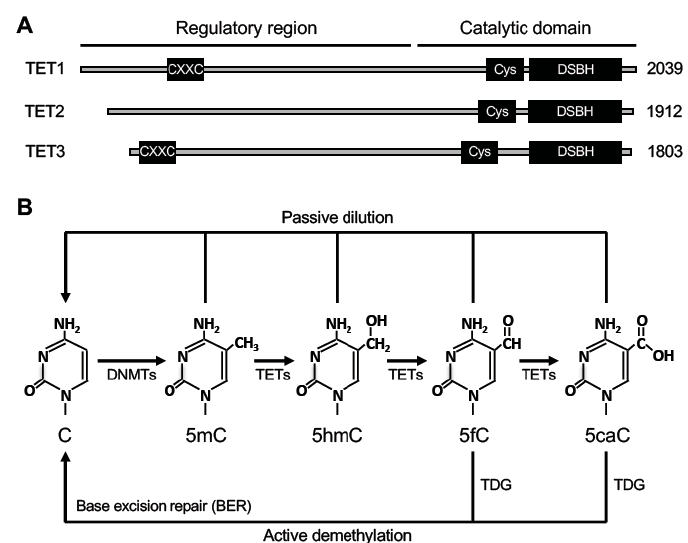
Figure 3. Ten-eleven translocation (TET) proteins and relevant DNA demethylation pathways. ( A ) The protein domains in TET proteins (TET1, TET2 and TET3) are shown (the sizes/amino acid numbers refer to mouse proteins). Their C-terminal catalytic domains contain two characteristic sequence features, a cysteine-rich region (Cys) and a double-stranded β helix (DSBH) fold. Their N-terminal regulatory regions are less conserved, with TET1 and TET3 containing a CXXC zinc finger domain. ( B ) DNA demethylation pathways involving TETs. TET proteins initiate DNA demethylation by oxidizing 5-methylcytosine (5mC) to 5-hydroxymethylcytosine (5hmC), which can be further oxidized to 5-formylcytosine (5fC) and 5-carboxylcytosine (5caC). 5fC and 5caC can be excised by thymine DNA glycosylase (TDG). The residual abasic site can then be repaired by the base excision repair (BER) pathway to complete ‘active’ demethylation. 5mC, 5hmC, 5fC, and 5caC can also be removed through DNA replication-coupled ‘passive’ dilution.